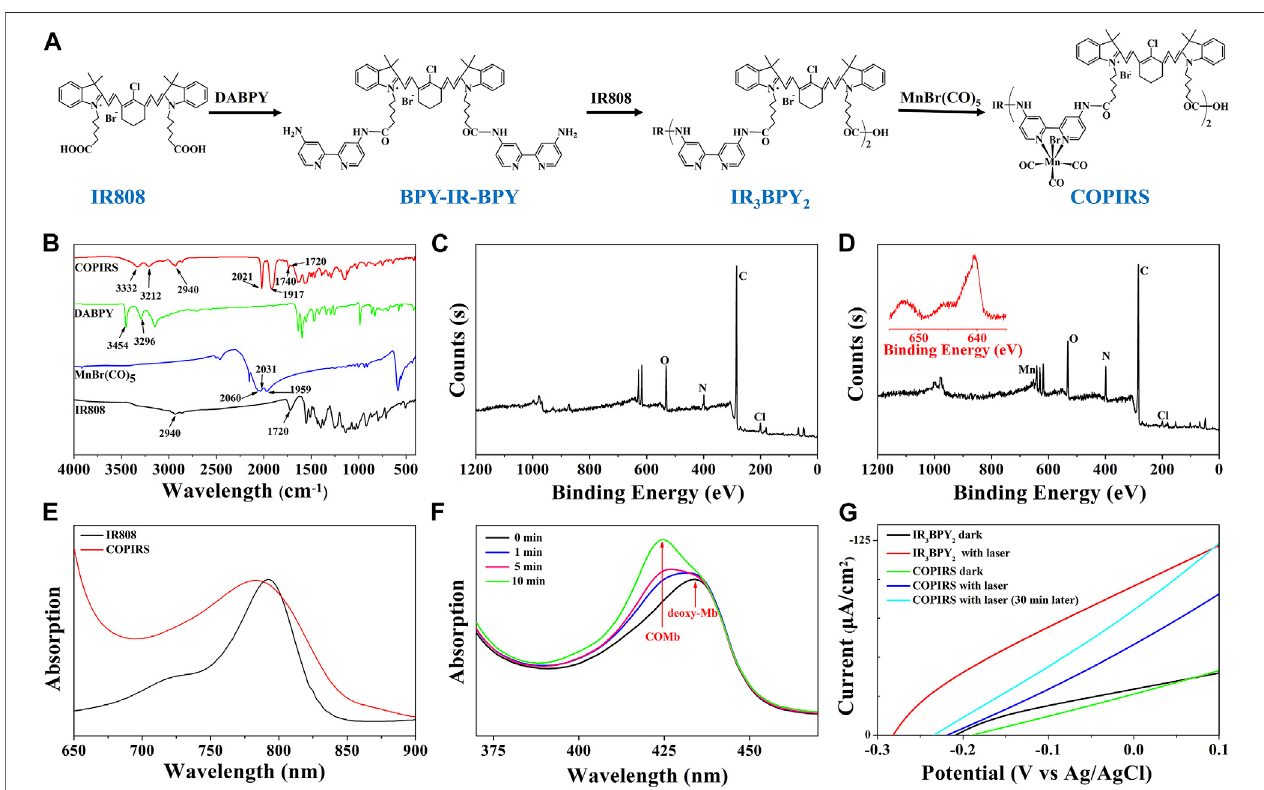
FIGURE 2 | Characterization of CO photo-induced release system (COPIRS); (A) The synthetic route of COPIRS. (B) FT-IR spectra ofIR808, MnBr(CO) 5 , DABPY, and COPIRS; (C) XPS result of IR808; (D) XPS result of COPIRS (inset: ampli fi cation of Mn (red) peak); (E) UV-vis spectra of IR808 and COPIRS; (F) UV-vis spectra of deoxy-Mb solution co-incubated with COPIRS before NIR irradiation and at 1, 5, and 10 min after NIR irradiation (MbCO: carbonmonoxy myoglobin); (G) Photocurrent measurements of IR 3 BPY 2 in dark and with laser (808 nm), COPIRS in dark, with laser (808 nm), and with laser (808 nm) after irradiation of 30 min through linear sweep voltammetry (LSV)